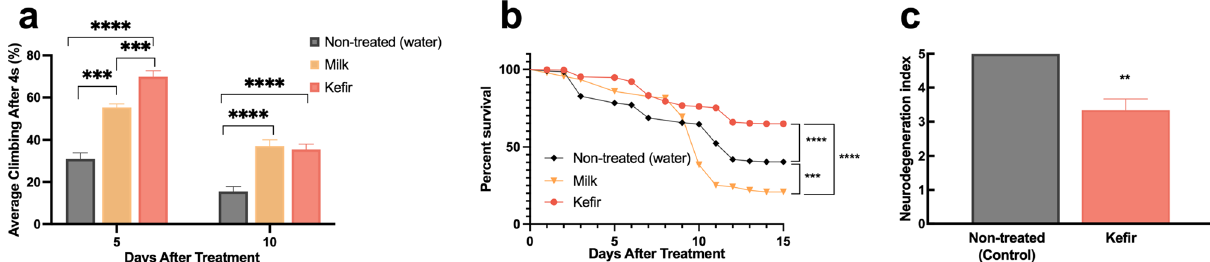
Figure 2. ( a ) Survival rate of non-treated, kefir, and milk-treated AD-like flies (n ≥ 90 in each group). The statistical significance is indicated as *** for P < 0.001 and **** for P < 0.0001 (log-rank, Mantel–Cox test). ( b ) AD-like flies climbing ability after kefir and milk treatment at 5 and 10 days after treatment (d.a.t.). Kefir-treated flies performed better than control at both tested ages, and better than milk-treated flies at 5 d.a.t.. At 10 d.a.t., flies treated with milk or kefir showed an equivalent performance. Data are shown as the mean ± S.E.M. n ≥ 90 in each group. ( c ) Neurodegenerative index of non-treated (control) and kefir treated AD-like flies (n = 10, 10 days after treatment). The statistical significance is indicated as ** for P < 0.01, *** for P < 0.001, **** for P < 0.0001 and (Unpaired two-tailed olites, we proceeded with testing cell and peptide free fractions. For each fraction, Tween80 0.01% was used as a vehicle, and three concentrations were tested: 0.1, 0.25 and 0.5 mg/mL. Vehicle and non-treated flies showed no difference in survival. On the other way, some fractions had a toxic effect on AD-like flies, with those displaying a lower survival rate in relation to vehicle-fed ones in the analyzed period. This happened for flies treated with Hex 0.5 mg/mL (P = 0,0290), DCM 0.1 and 0.5 mg/mL (P = 0,0006 and P < 0.0001, respectively), plus ButOH 0.25 mg/mL (P = 0,0084) (Fig. 3). Despite that, survival rate was improved on flies treated with EtOAc 0.5 mg/mL (P = 0.0005) and ButOH 0.5 mg/mL (P < 0.0001), which improved AD- like flies’ survival rate as much as the kefir treatment (Fig. 3e). On the RING assay, vehicle treatment also did not change flies climbing ability in relation to control flies (fed with non-treatment food) both at 5 and 10 d.a.t. (data not shown). At 5 d.a.t., treatment with at least one concentration of each fraction improved AD-like flies climbing ability when compared with the ones treated only with vehicle (Fig. 4). Flies treated with DCM fraction performed the best on the RING assay when the 0.25 mg/ mL concentration was used (P = 0,0051), while for both EtOAc and ButOH the best concentration was 0.5 mg/ mL (P = 0,0006 and P = 0,0124, respectively). Two concentrations of Hex fraction increased AD-like flies climbing ability: 0.1 (P = 0,0096) and 0.5 mg/mL (P = 0.0009), being the last, the most efficient. At 10 d.a.t., EtOAc-treated flies did not perform better than vehicle-fed ones. Flies treated with Hex 0.1 mg/